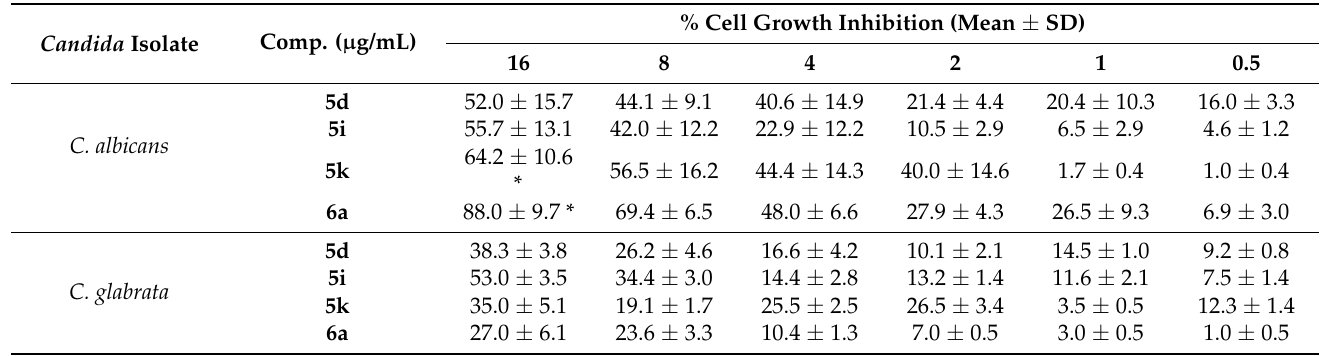
Table 3. Antifungal activity of 5d , 5i , 5k and 6a against the fungal isolates. Candida